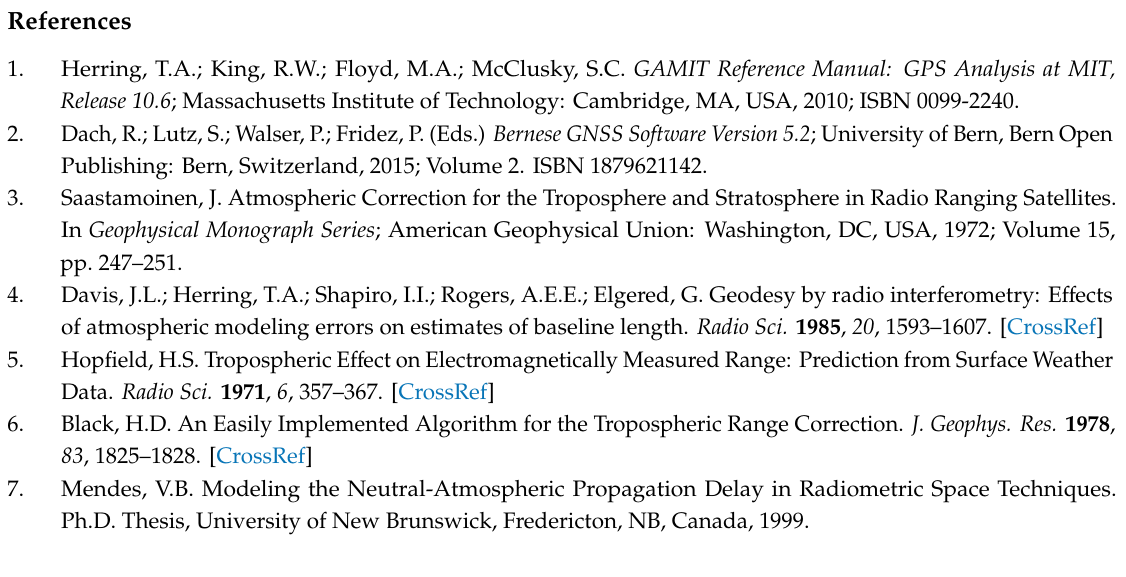
Figure 6b was accessed from www.ecmwf.int / en / forecasts / charts / under the policy and permission from ECMWF. We also thank NOAA for providing the Integrated Global Radiosonde Archive (IGRA). Conflicts of Interest: The authors declare no conflict of